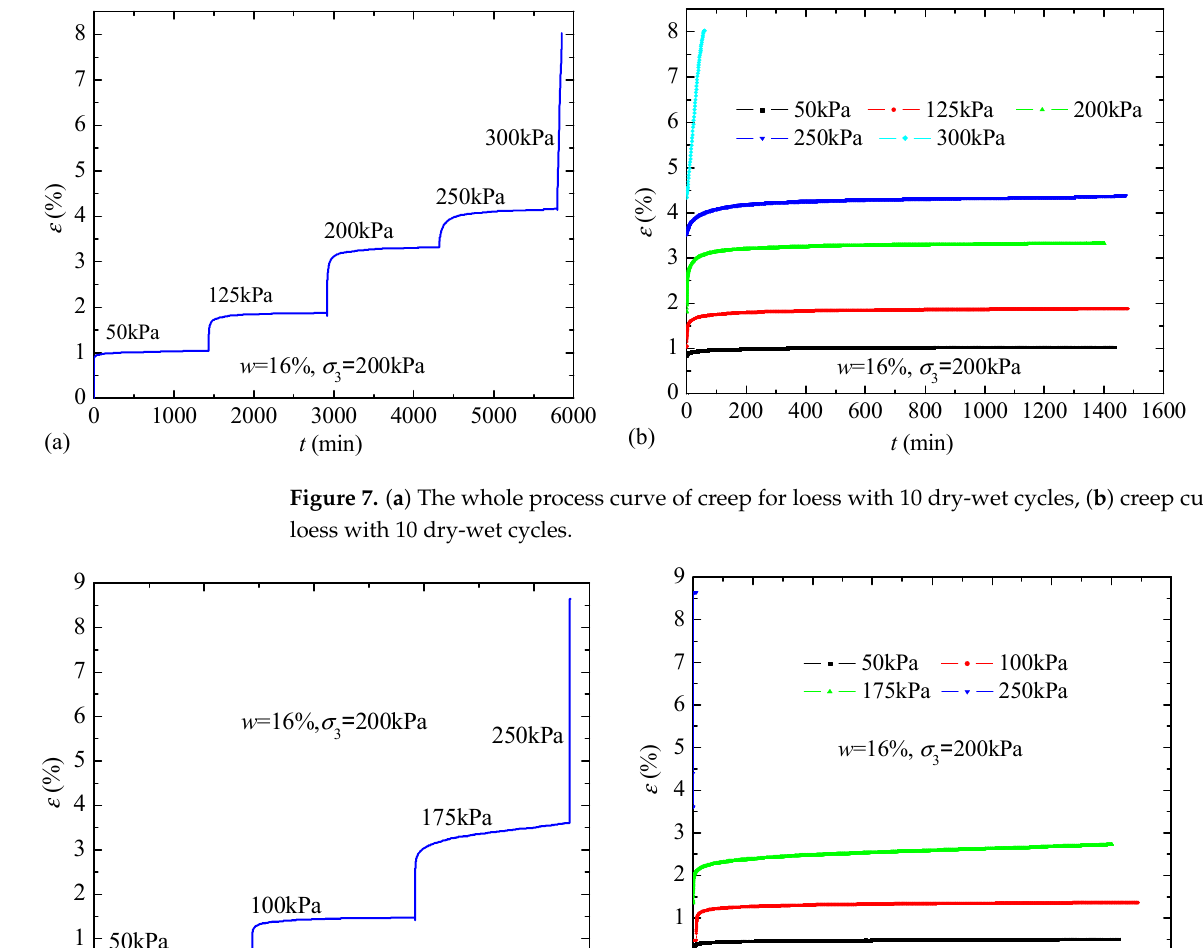
Figure 6. ( a ) The whole process curve of creep for loess with 5 dry-wet cycles, ( b ) creep curves of loess with 5 dry-wet cycles.